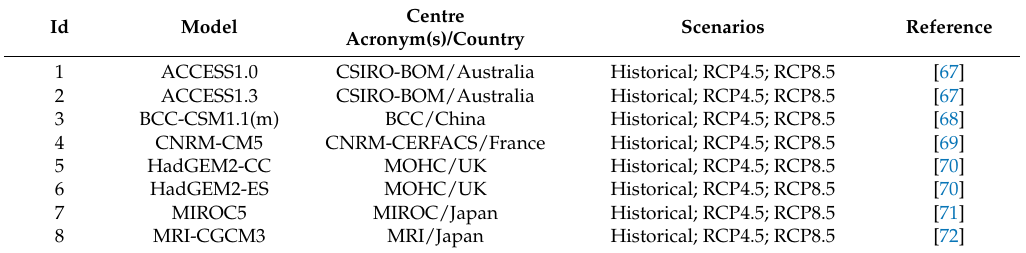
Table 1. Summary of global climate models from CMIP5 simulation